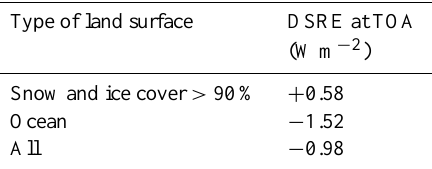
Table 3. Four-day average DSRE at the TOA north of 60 ◦ N, over regions significantly influenced by European pollution ( > 50% of total PM 2 . 5 column due to in-domain anthropogenic and biomass burning emissions). Type of land surface DSRE at TOA (Wm − 2 ) Snow and ice cover > 90% + 0.58 Ocean − 1.52 −